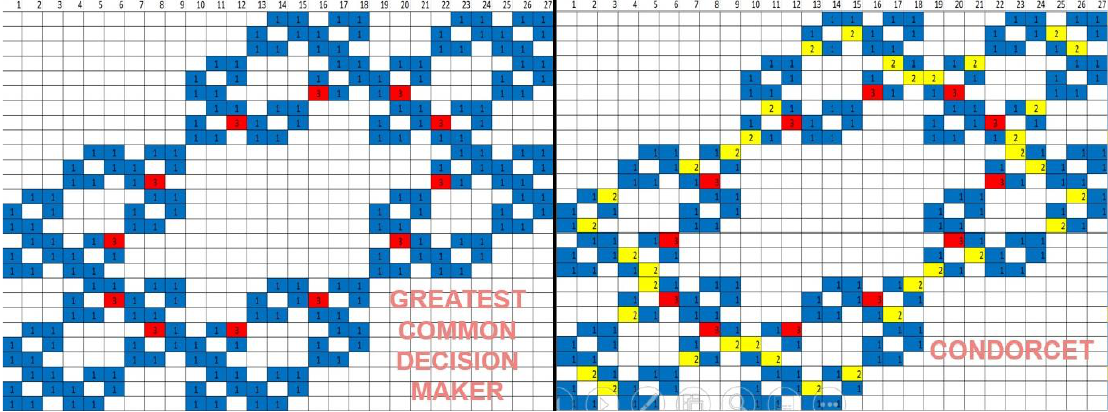
Figure 14. Comparison between the color maps (or heatmaps) for the Greatest Common Decision Maker and Condorcet methods for n = 3.